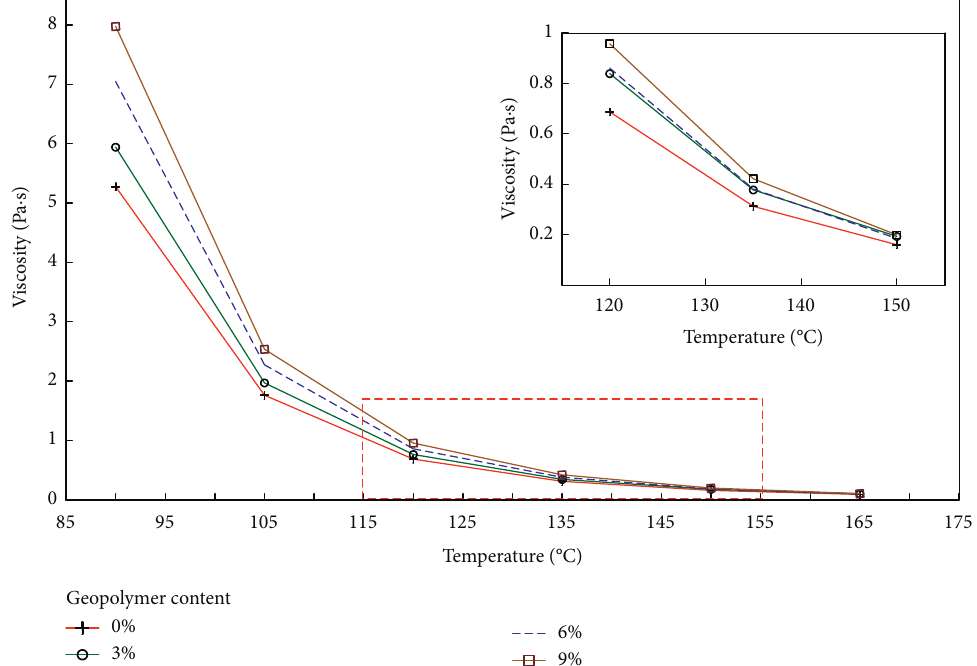
Figure 6: Asphalt binder viscosity changing with the temperature at different geopolymer